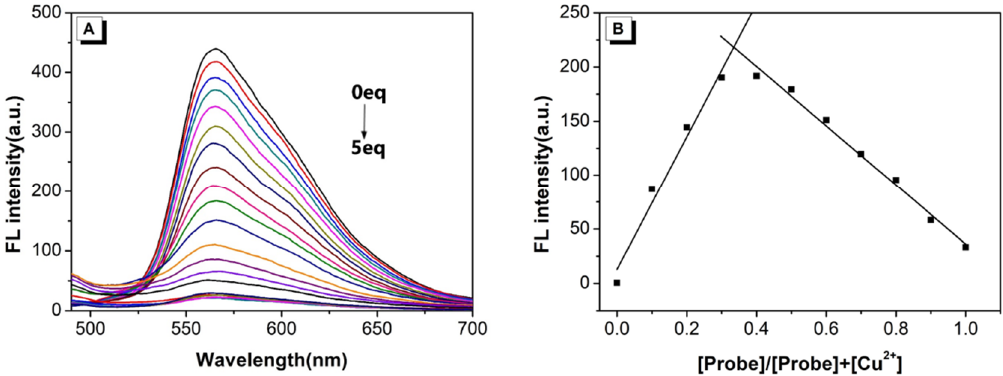
Figure 5. ( A ) Fluorescence spectra on addition of Cu 2+ to the probe; ( B ) Job’s plot for the determination of the stoichiometry of L and Cu 2+ in the mixture of THF/H 2 O (V THF :V H2O = 4/1), the total concentration of L and Cu 2+ was 40 μM.